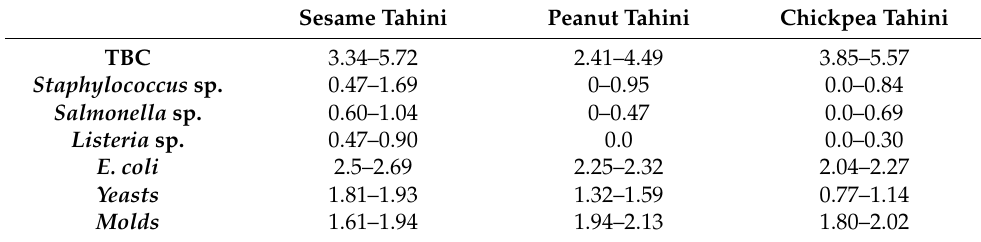
Table 1. Average contamination levels in bulk tahini samples handled commonly in markets